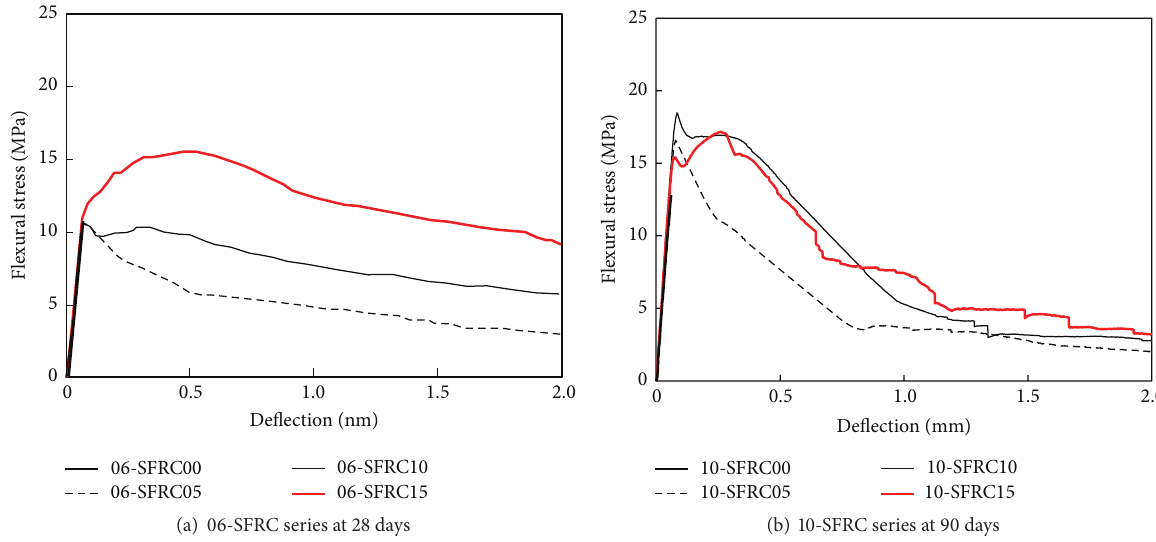
Figure 1: Typical load-deflection curves of HP-SFRC